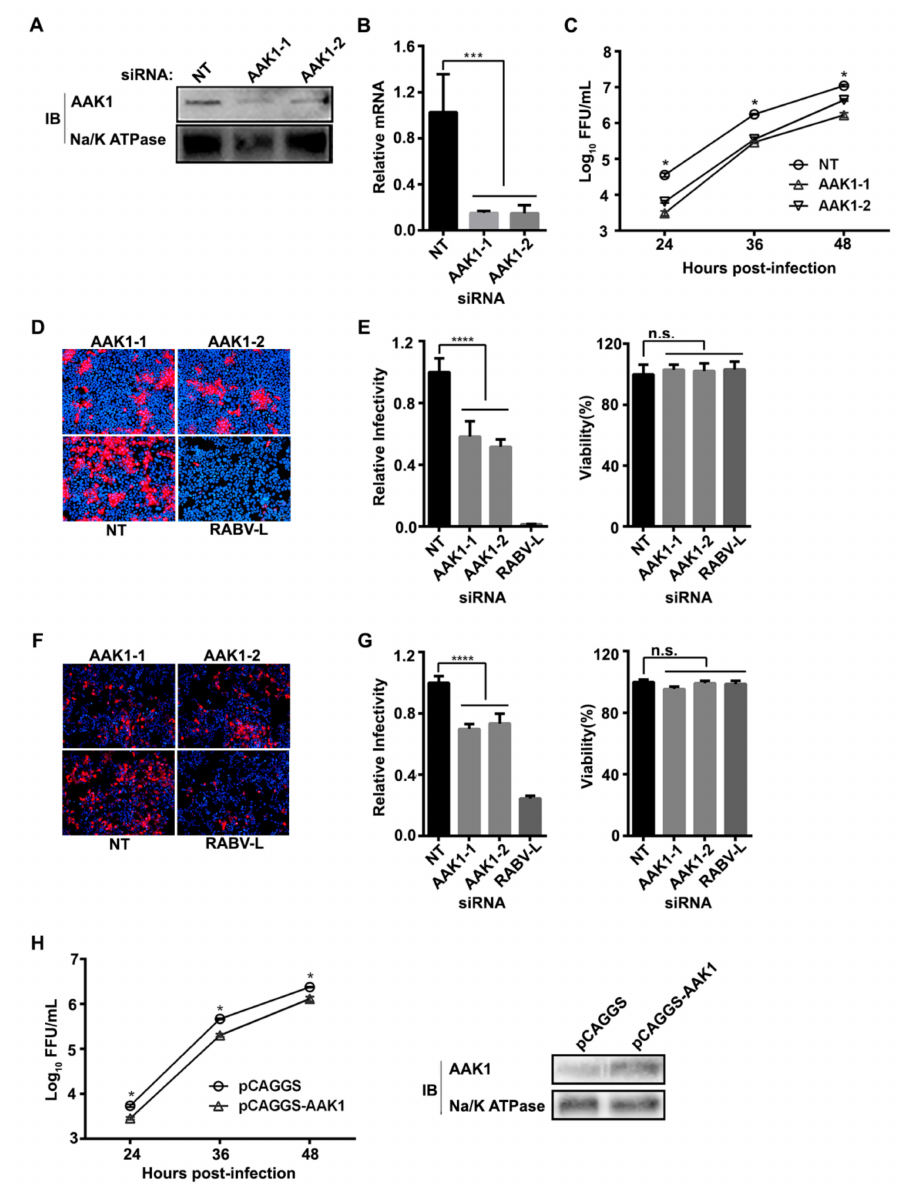
Figure 1. AAK1 is required for RABV infection. ( A ) HEK293 cells were transfected with siRNAs AAK1-1, AAK1-2, RABV-L, or NT. AAK1 expression level was determined by Western blotting. Numbers represent the relative ratios of AAK1 to Na / K ATPase protein normalized to the NT control. ( B ) mRNA levels of AAK1 were determined by qRT-PCR in cells followed by siRNA transfection. A one-way ANOVA was used for the statistical analysis, ***, p < 0.001. ( C ) Knock-down of AAK1 inhibits ERA-mCherry replication in HEK293 cells. Viral titers were determined as focus forming units (FFU) in BSR-T7 / 5 cells. Multiple t tests were used for the statistical analysis, *, p < 0.05. ( D – G ) Representative images of ERA-mCherry-infected HEK-293 cells ( D ) or SK cells ( F ) transfected with siRNAs AAK1-1, AAK1-2, RABV-L or NT. The relative infection ratio (normalized to NT siRNA-transfected cells) of RABV in HEK-293 cells ( E ) or SK cells ( G ) transfected with the indicated siRNAs (left). Cell viability was measured at 48 h after siRNA transfection (right). Data are relative fluorescence values normalized to the level of the NT control. A one-way ANOVA was used for the statistical analysis. ****, p < 0.0001; n.s., not significant. ( H ) The growth kinetics of ERA-mCherry (MOI = 0.05) in pCAGGS-AAK1-transfected HEK293 cells. AAK1 overexpression was confirmed by Western blotting. A one-way ANOVA was used for the statistical analysis. *, p < 0.05. Values represent the mean ±